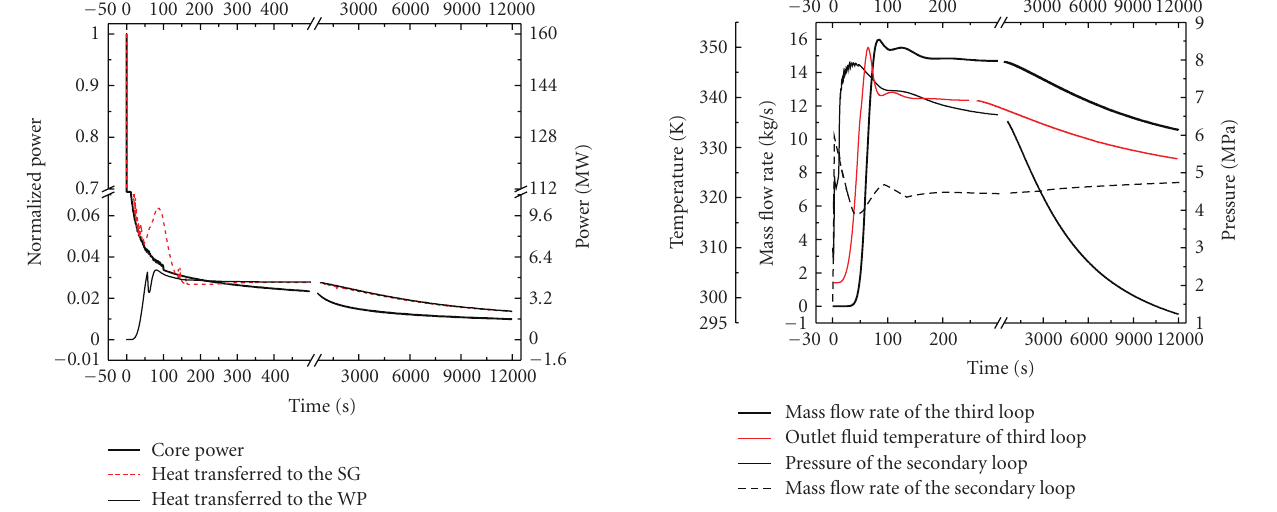
Figure 7: Mass flow rate and pressure of the secondary loop, mass flow rate and outlet temperature of the third